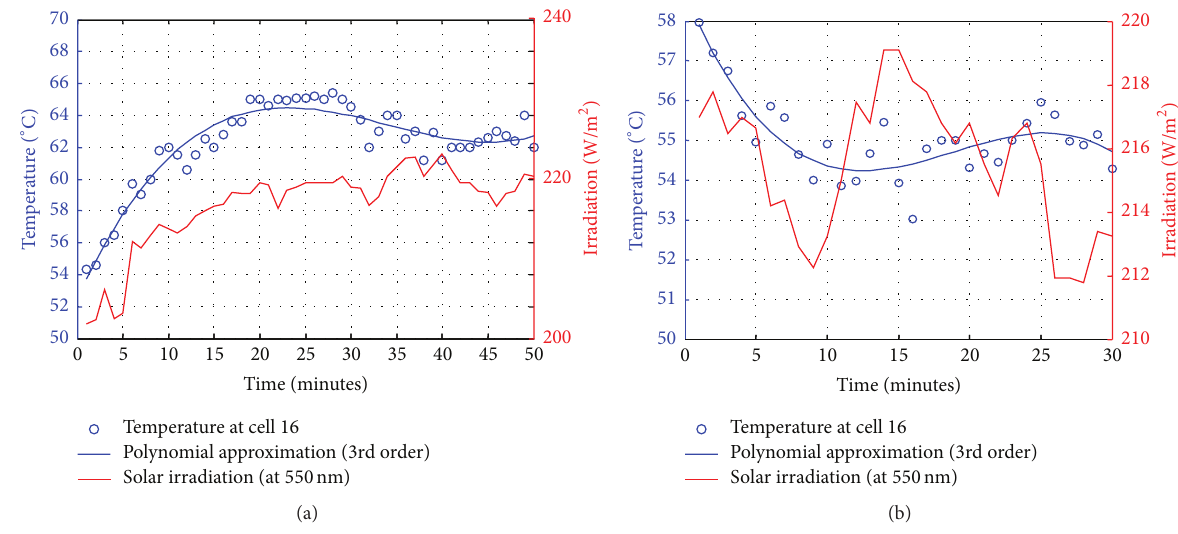
Figure 5: Thermal transient of cell 16 of module A. (a) For a current step up. (b) For a current step down.